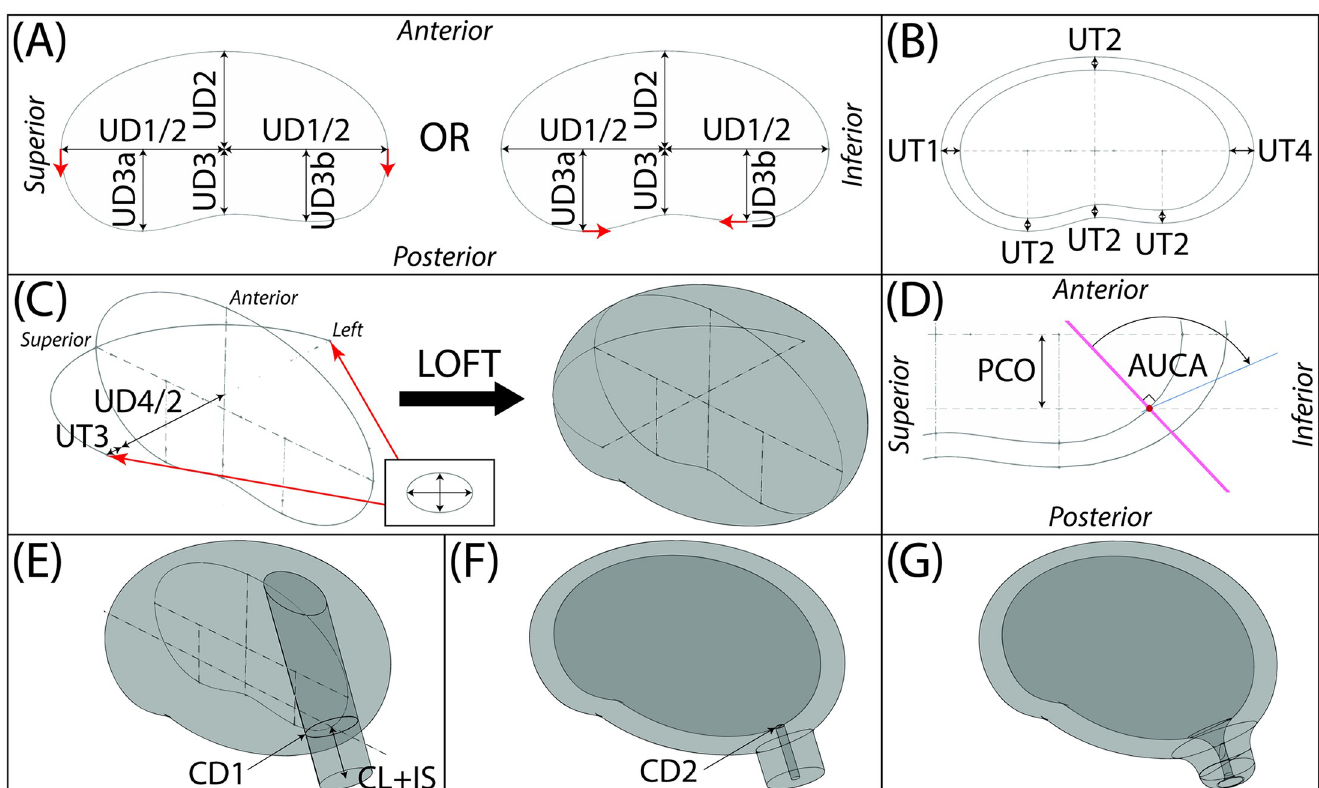
Fig 5. CAD model construction. (A) Inner uterine wall sagittal shape built from ultrasound measurements. Posterior side is built with either a spline (left) or ellipses and a spline (right). Red arrows indicate where tangency constraints have been applied. (B) Outer uterine wall sagittal shape built by adding uterine wall thickness ultrasound measurements to inner uterine wall sagittal shape. (C) Outer uterine loft completed using scaled ellipses as left and right profiles and a half ellipse as the guide curve. (D) Internal os is placed at a distance of the perpendicular cervical offset (PCO) from the inferior-superior intrauterine diameter (UD1) on the posterior wall and a plane at an angle of the anterior uterocervical angle (AUCA) to the perpendicular of the posterior wall. (E) Cervix is added by extruding a circle with diameter of the outer cervical diameter (CD1) away from the outer uterine loft a length of the combined cervical and isthmus lengths (CL+IS) and up to the outer surface of the uterine loft. (F) Intrauterine cavity is made using a lofted cut and the cervical canal is added by an extruded cut to the end surface of the cervix and the surface of the intrauterine cavity. (G) Fillets are added at the internal os, external os, exocervix, and uterocervical